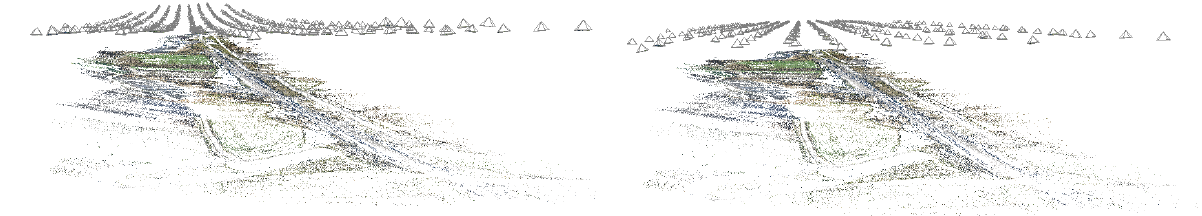
Figure 3: Results of the photogrammetric reconstruction without (left) and with additional GPS positions in the bundle adjustment (right). The direct comparison shows the reduction of the initially clearly visible distortion of image block and object points. that by calculating the deviations of the calculated camera posi- tions from the Structure-from-Motion result and penalize in the optimization step the deviation to their measured GPS